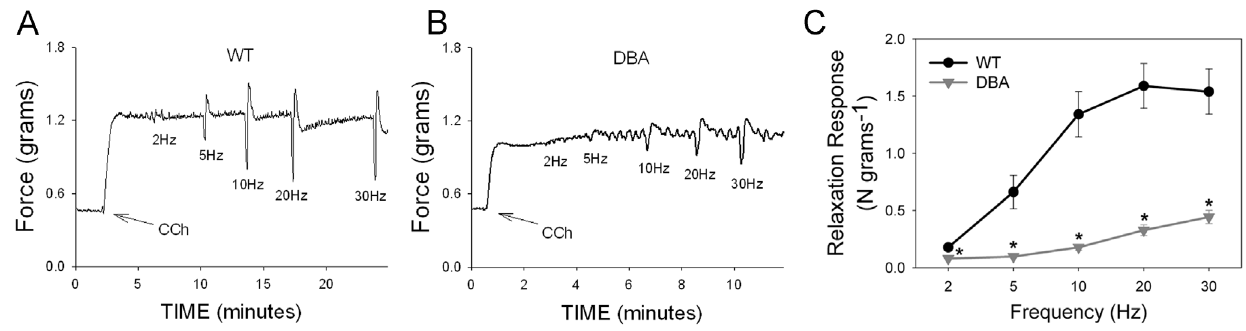
Figure 3. Effect of myosin Va deficiency on nerve mediated relaxation in mouse gastric fundus. (A) Representative tracing showing frequency dependent relaxation in a WT animal. (B) Representative tracing showing reduced relaxations in response to EFS in a DBA mouse. (C) Quantification of frequency-relaxation responses in WT and DBA mice. Note that in DBA mice, relaxation responses are markedly decreased. [n=12 in each group; *=significantly lower than WT, unpaired t-test].